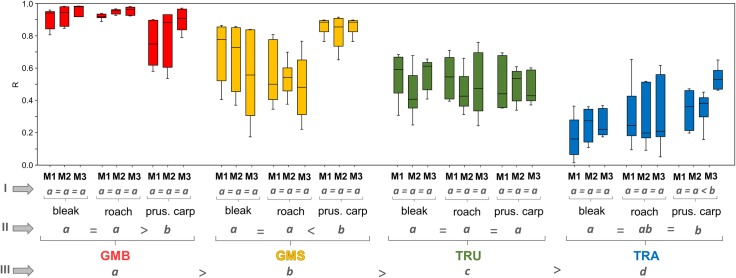
Boxplots for repeatability derived from pairwise Mantel tests of intra-measurer R values (for data see S5 Table).Nine pairwise R values, obtained from the same measurer’s data, were used for each box. Each box represents the 25% and 75% quartiles while the line in the box represents the median. The whiskers show the highest and lowest values within the dataset. In rows indicated by grey Roman numerals, the datasets were analysed at different levels, i.e. I (measurer; n = 9), II (species; n = 27) and III (method; n = 81). Groups with the same letter did not differ significantly (p < 0.05) using the Kruskal-Wallis test. Color codes corresponds with Figs 1 and 3.